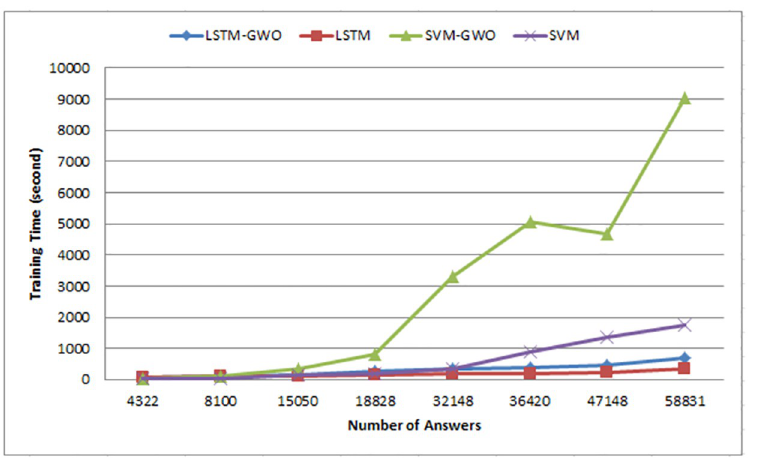
Fig 31. Training time of LSTM-GWO and other